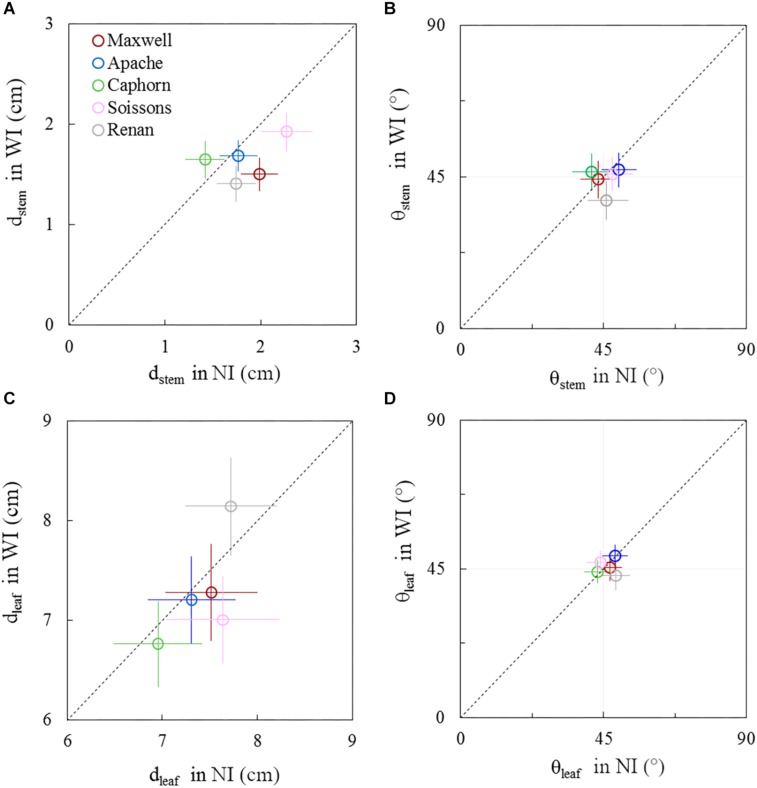
Horizontal spacing and azimuth orientation of stems and leaves in WI treatments vs. NI treatments, at 722°Cd. The stem spread (dstem; A), leaf spread (dleaf; C), stem azimuth angle (θstem; B), and leaf azimuth angle (θleaf; D). Symbols represent the mean values taking into account all axes, for 30–60 plants per treatment. Error bars represent 95% confidence intervals of the mean estimates. The dotted line represents the line 1:1.